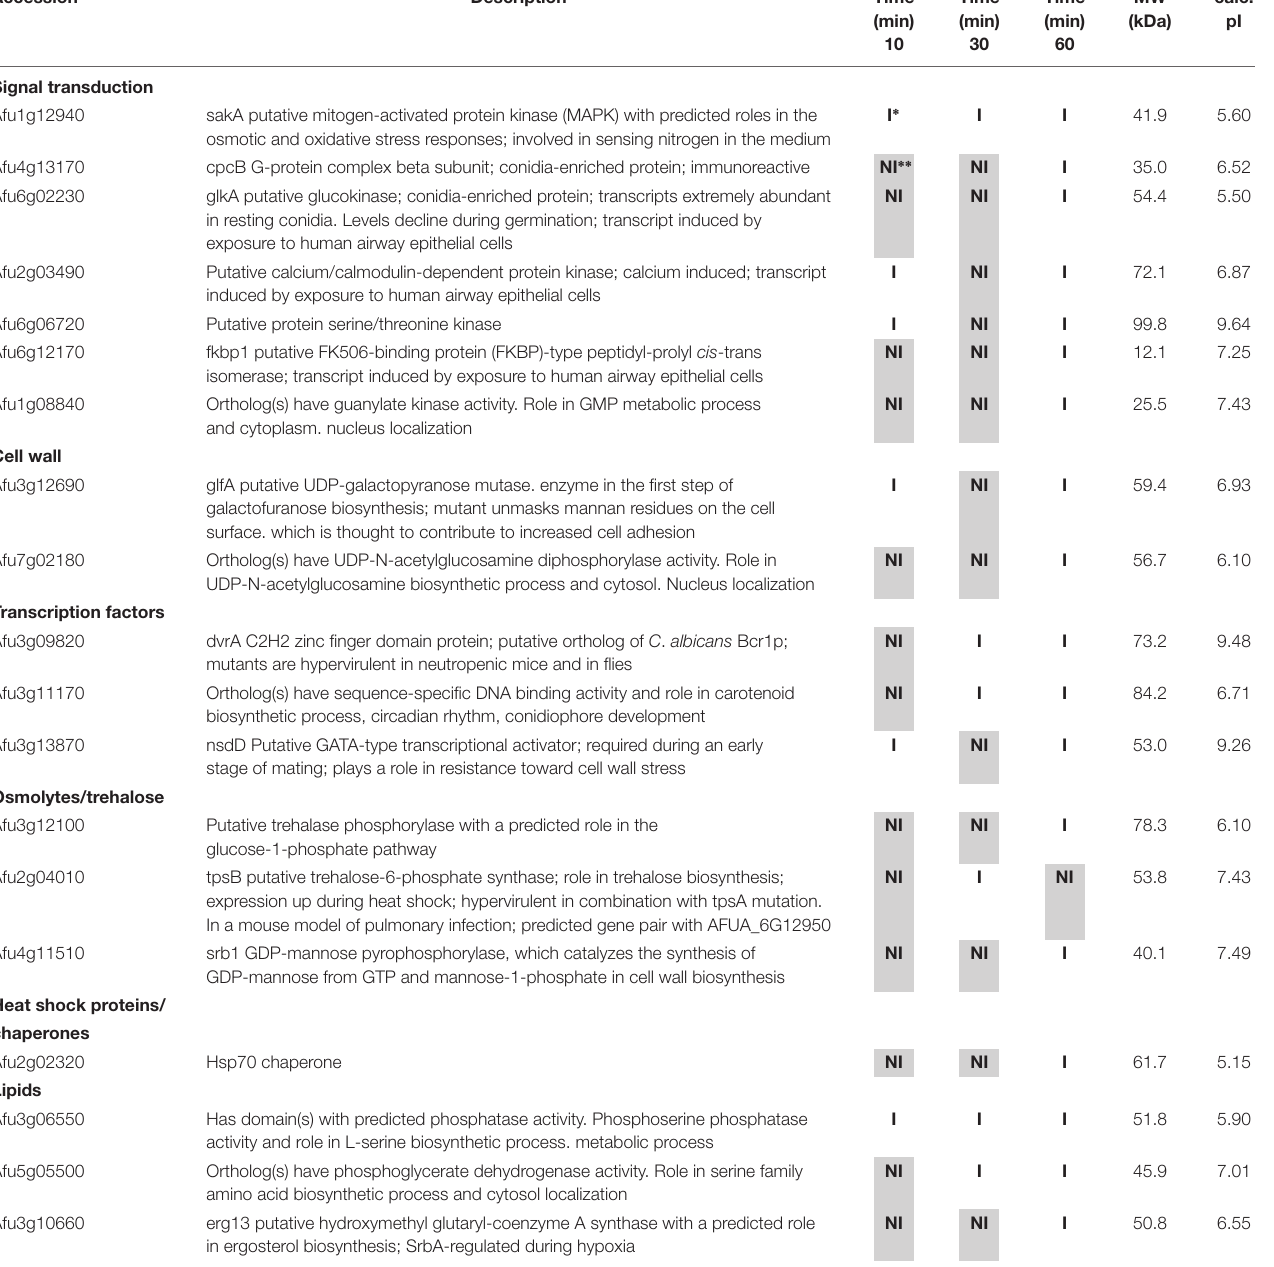
TABLE 1 | Selected proteins interacting with SakA::GFP identified during osmotic stress. Accession